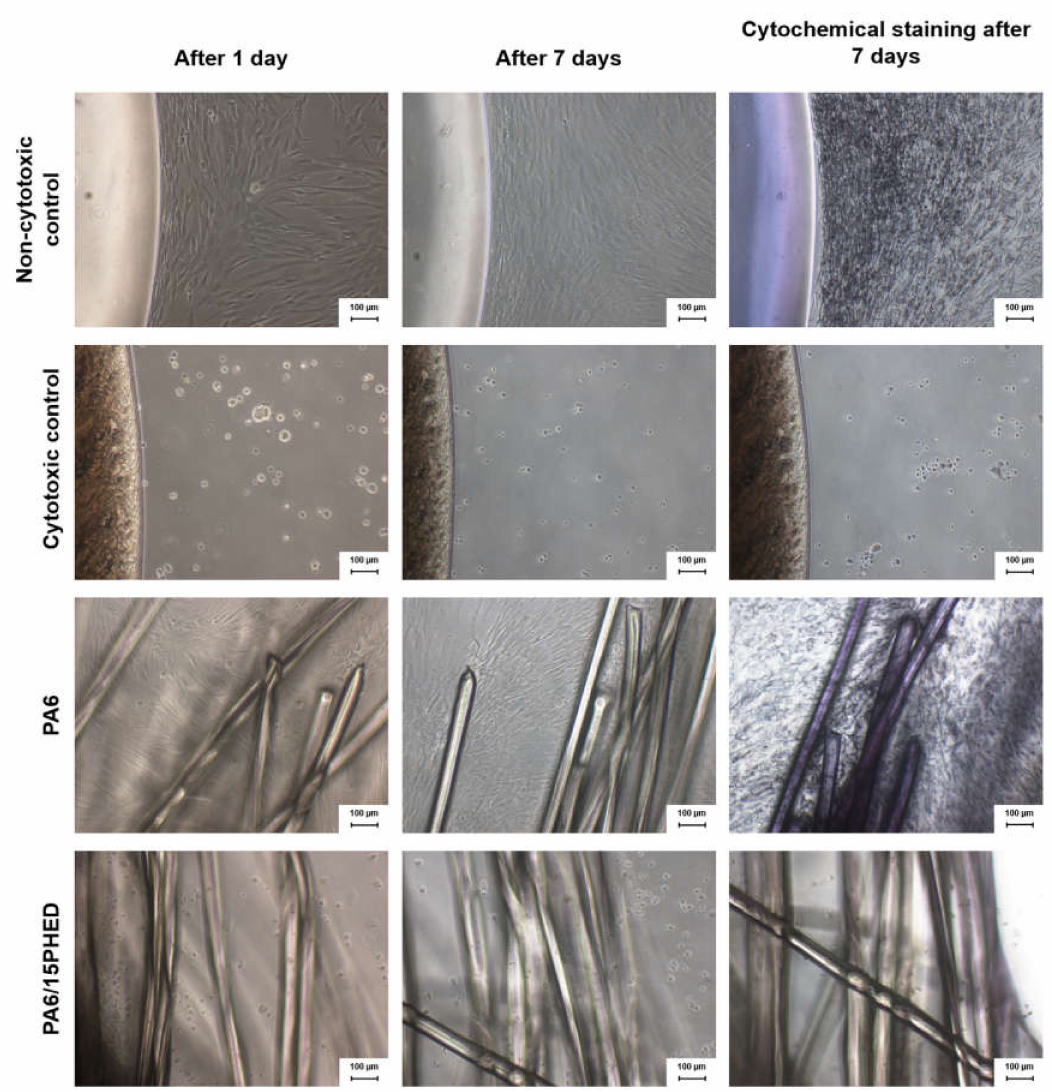
Figure 8. The results of a daily monitoring of the grown human stromal (stem) cell culture from adipose tissue (ADSCs) in the negative (non-cytotoxic) and positive (cytotoxic) controls, and in the immediate vicinity of the PA6 and PA6/15PHED fiber samples after 1 and 7 days of incubation as well as after cytochemical staining of the 7-day incubated samples.